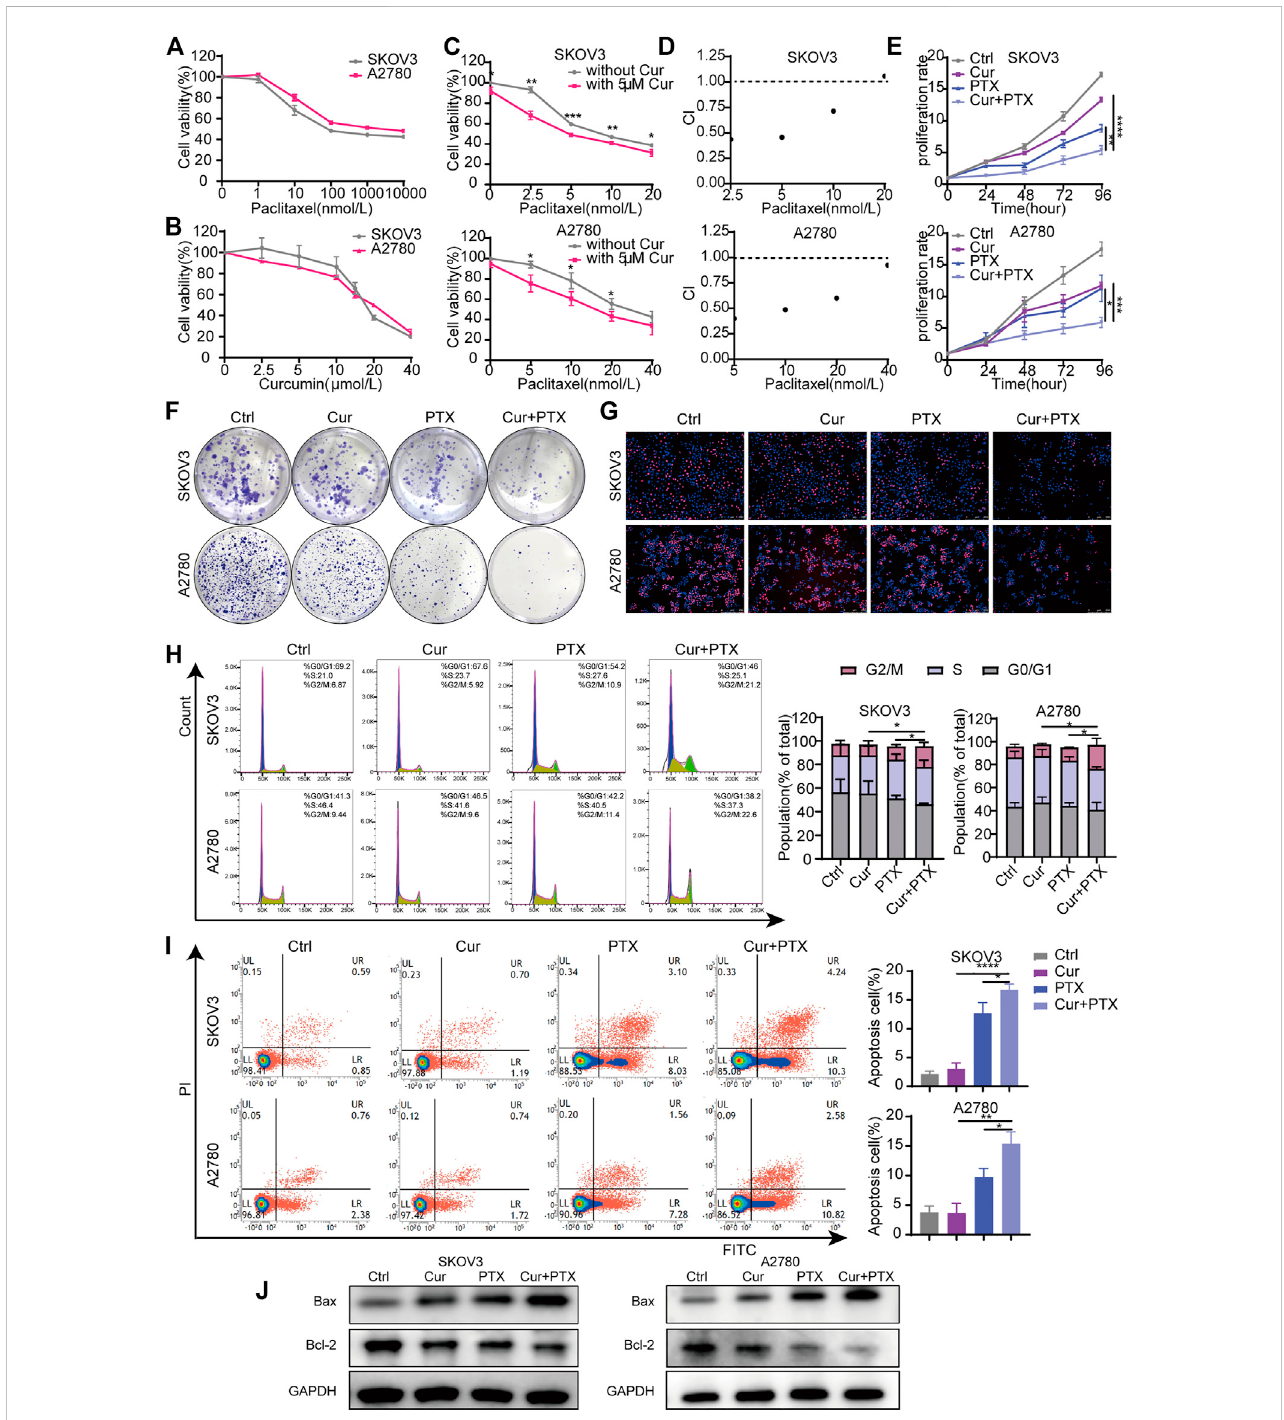
FIGURE 1 Cur and PTX exerts synergistic cytotoxicity in ovarian cancer cells. (A,B) Drug-response curves of survival after a series of concentrations treatment of PTX, or Cur in the ovarian cancer cell lines measured by CCK-8 assay at 48 h. (C) Dose – response curves of PTX with or without 5 μ M Cur for the ovarian cancercells. CCK-8assayswasusedtodeterminecellviability. (D) Thecombinationindex(CI)ofeachcombined treatmentwascalculated byusingCalcuSyn software. CI > 1 indicates antagonist effect; CI = 1 indicates additive effect; CI < 1 indicates synergistic effect. (E – G) The proliferative capacity of ovarian cancer cells, treated with DMSO, Cur, PTX ortheircombination, wereassessedby CCK-8assays, colony-formation assays and Eduincorporation assays. (H,I) The cell cycle progression and apoptosis of ovarian cancer cells treated with DMSO, Cur, PTX or their combination for 48 h, detected by Flow cytometry. (J) TheexpressionofBaxandBcl-2afterindicatedtreatmentsmonitoredbyWesternblotting,GAPDHwasusedasaloadingcontrol.Dataarerepresentativeofat least three independent experiments and presented as the mean ± SD. * p < .05, ** p < .01, *** p < .001, **** p <